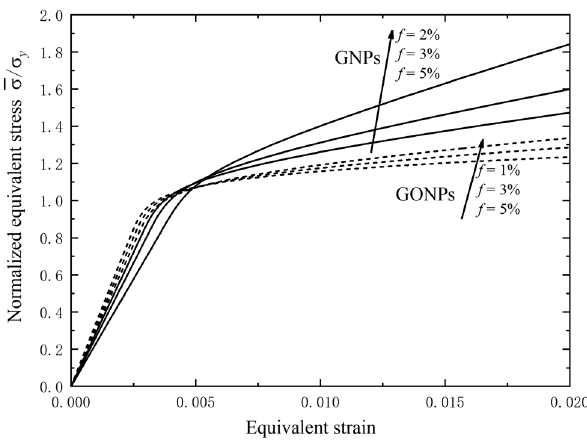
Figure 6: The normalized equivalent stress – strain curves of the nanoplate composite with the fi ller volume fractions.